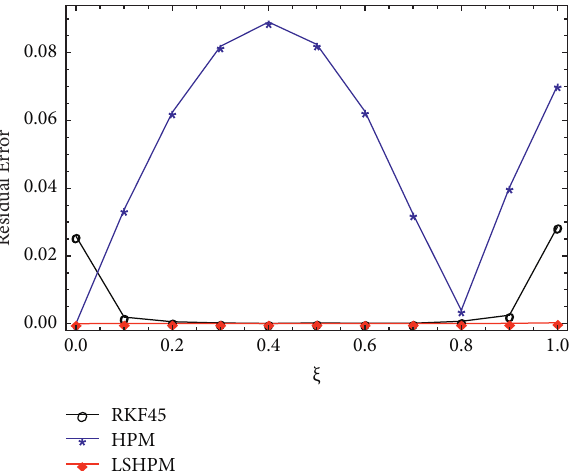
Figure 2: Comparison of errors for RKF45, HPM, and LSHPM when R � 1 ,M